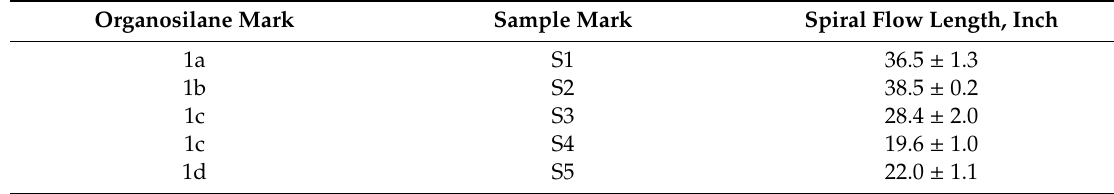
Table 5. EMMI-Epoxy Molding Materials Institute spiral flow length measurements.